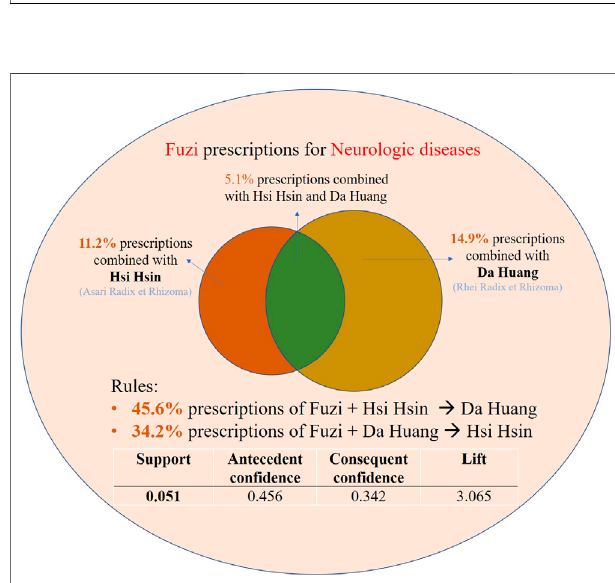
FIGURE 3 | The interpretation example of the association rules of Fuzi – Dahuang – Hsihsin herbal pair derived from market basket analysis. Theassociation rulesweredemonstrated in thefollowingthree measures: support, con fi dence, and lift. 1) The “ support ” was the relative frequency that the rule showed up in the given dataset. 2) The “ con fi dence ” measured the reliability of the inference made by a rule. For example, an association rule X (antecedent factor) to Y (consequent factor) was established by the estimate of the conditional probability of Y given X (antecedent con fi dence) or X given Y (consequent con fi dence), and high con fi dence indicated a strong association rule. 3) The “ lift ” was the likelihood of prescribing both drugs compared with a single drug. Lift value above one means there was a positive correlation between the two drugs. The higher the lift value, the more likely the two drugs were to be prescribed